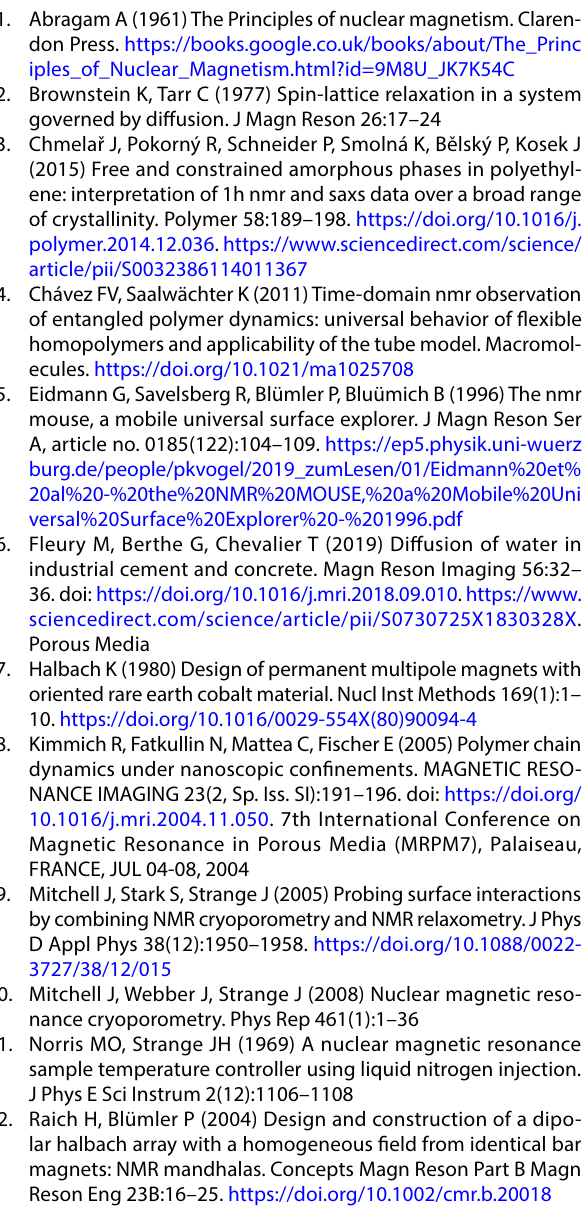
Fig. 29 MRI of pore size distributions in fault sealing oil reservoir rock core samples by cryoporometric filtering techniques.